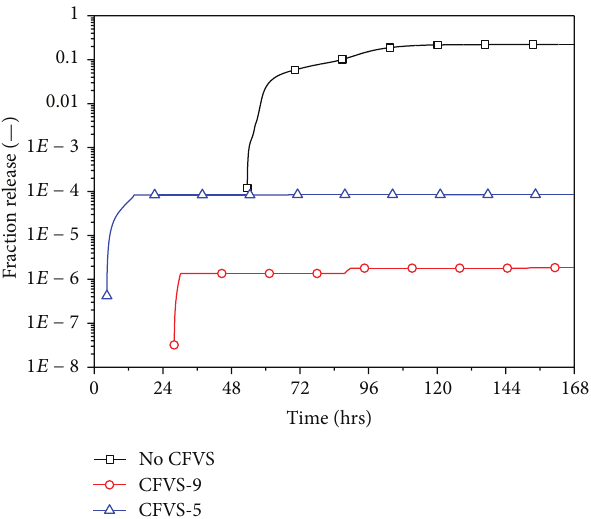
Figure 8: Containment pressure history in LBLOCA.